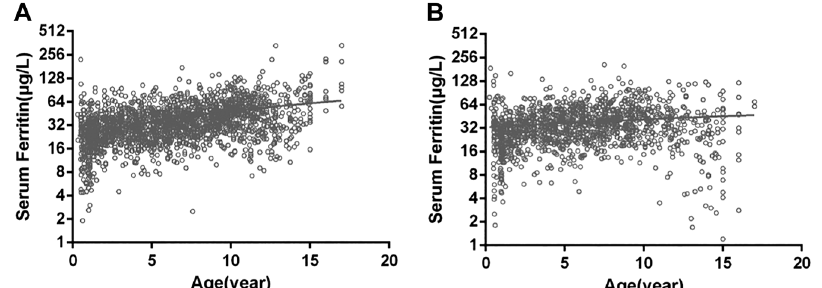
Figure 1: Correlation between age and serum ferritin